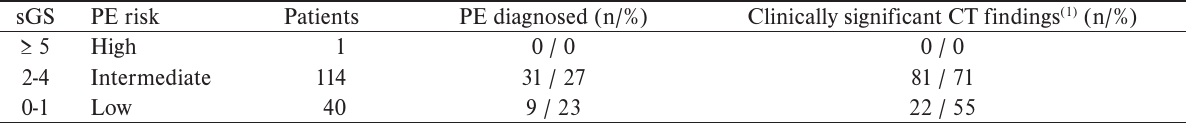
Table 3. CTPA findings in relation to the sGS based three-level risk stratification